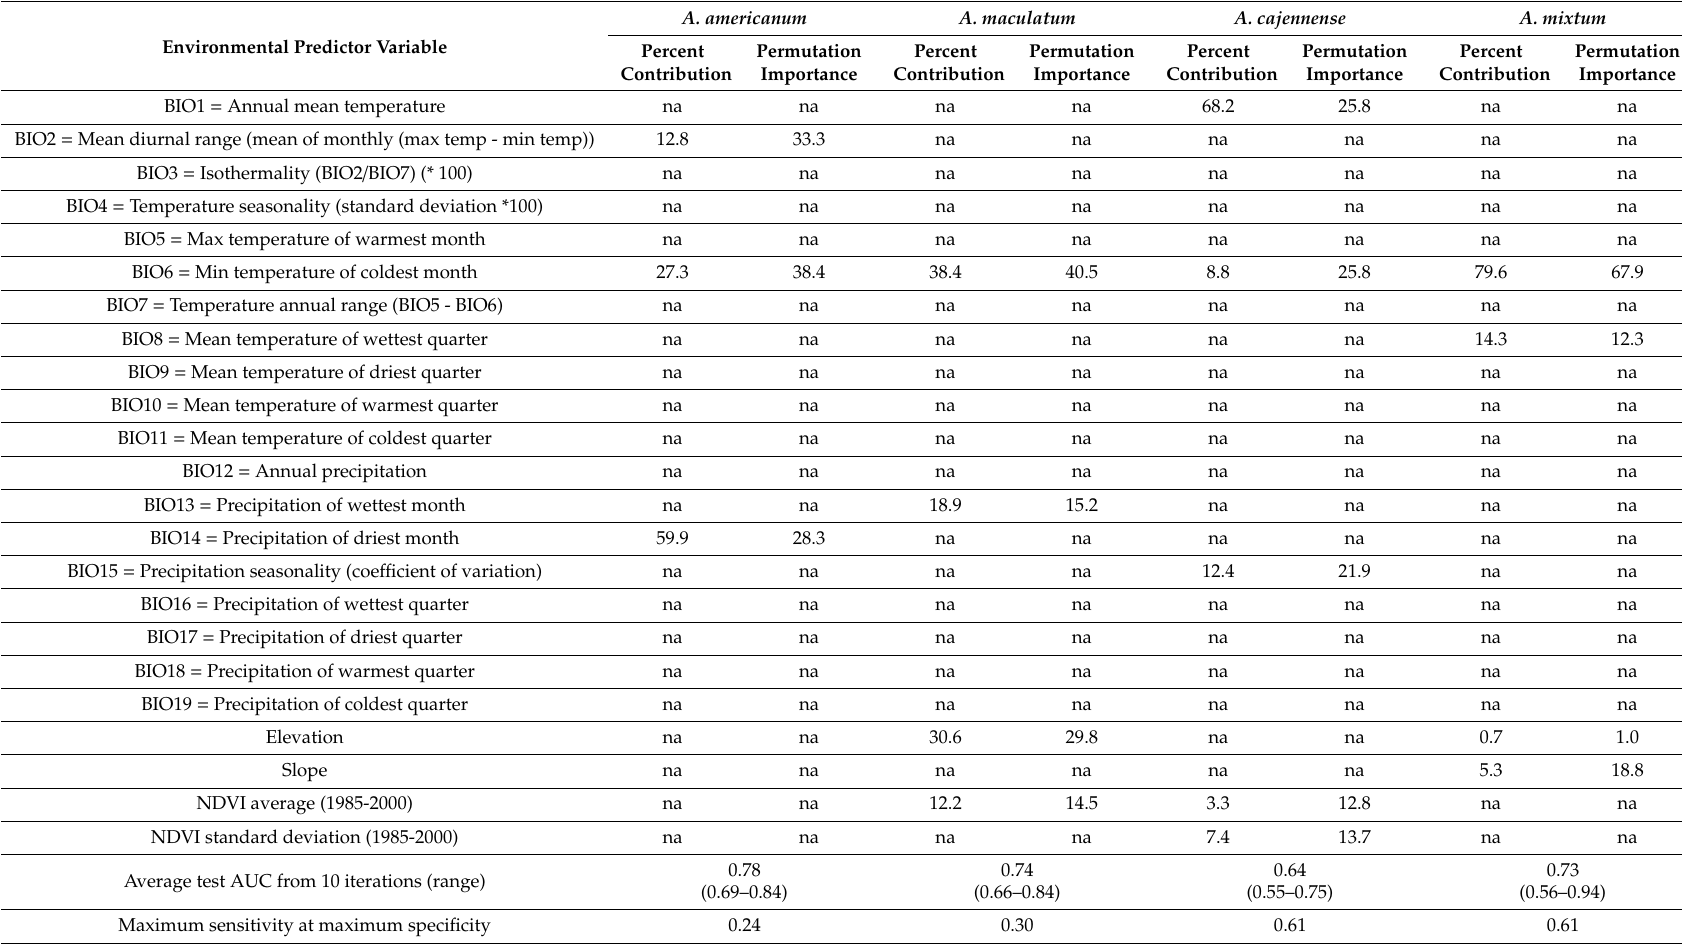
NDVI: normalized di ff erence vegetation index, AUC: average area under the curve (of receiver operator characteristics), na: Variable not included in final model due to collinearity with other variables that were considered more biologically important and / or contributed more to the